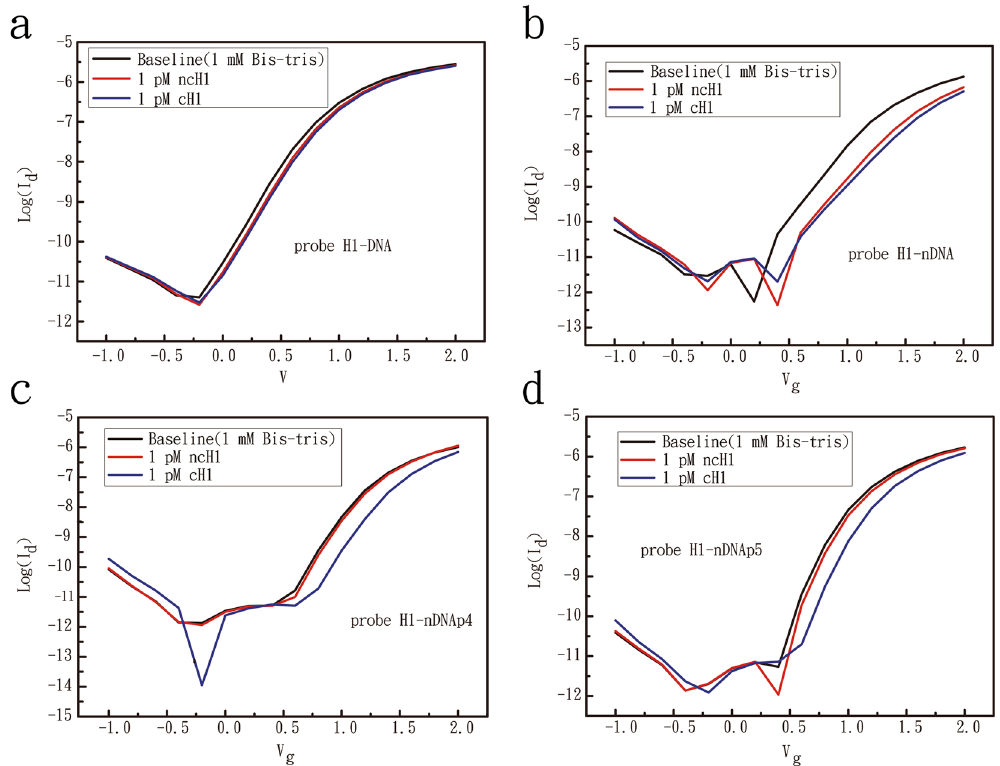
Figure 2. Experiments performed on poly-Si NWFET devices for testing the DNA-binding specificity of probe H1-DNA ( a ), H1-nDNA ( b ), H1-nDNAp4 ( c ), and H1-nDNAp5 ( d ) oligomers. The concentration of complementary (cH1) and non-complementary (ncH1) target sequences was 1 pM, and experimental results were measured in 1 mM